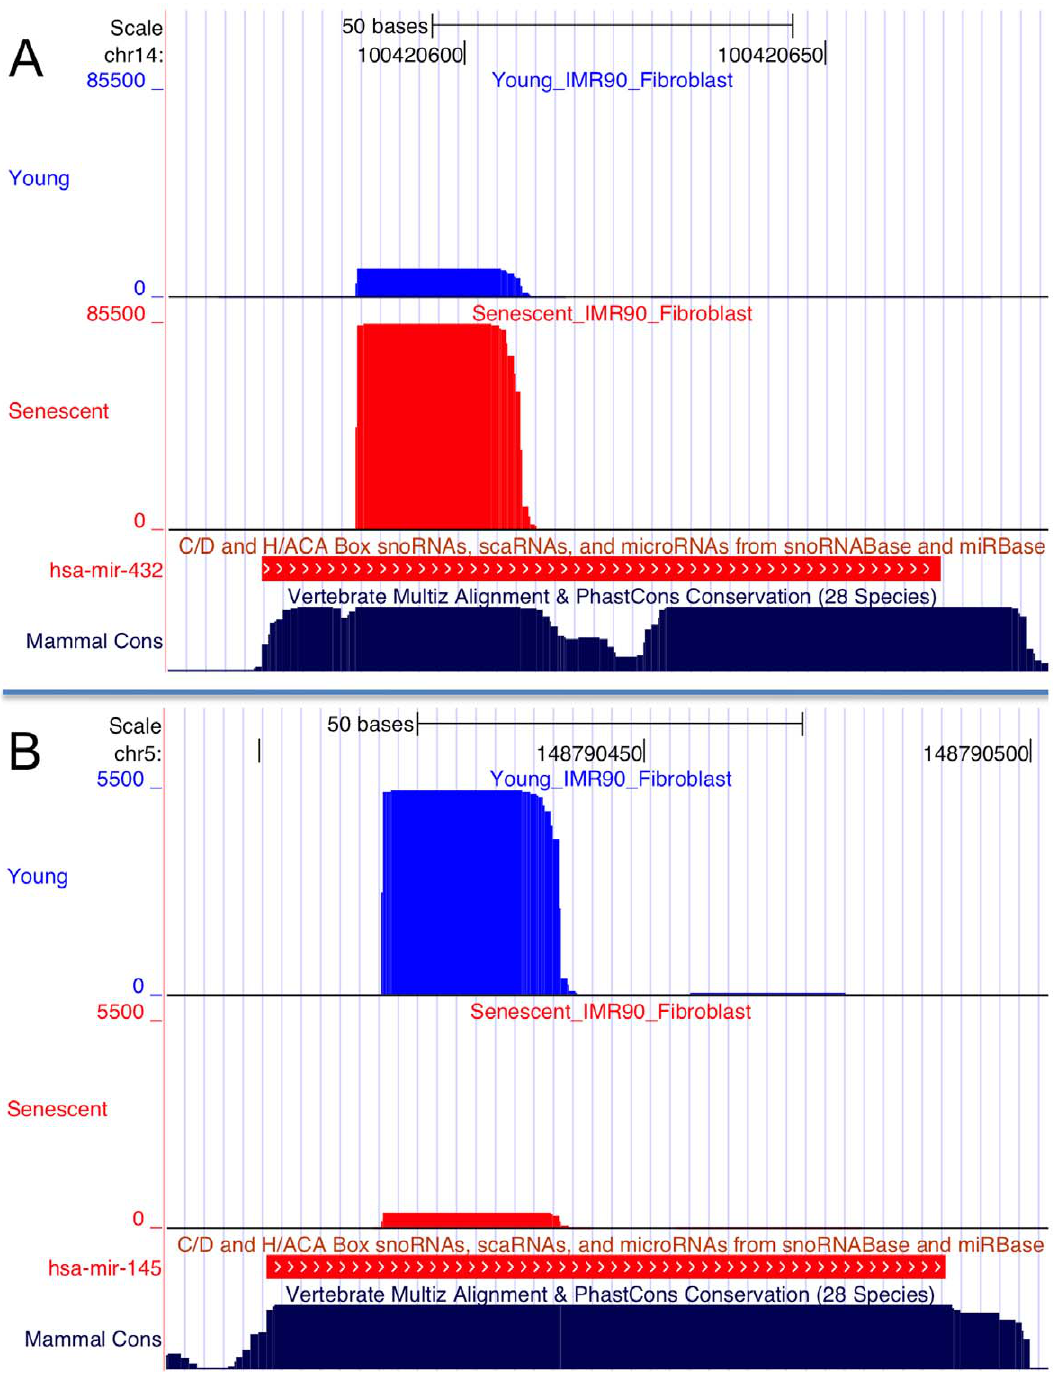
Figure 2. Examples of known miRNAs that are regulated in IMR90 senescence, showing sequence depth. UCSC genome browser views of two miRNAs aligned to the human genome. Reads from young IMR90 cells are shown in blue, and reads from senescent cells in red (number of reads is shown on the y-axis). (A) mir-432; (B) mir-145. The miRNAs (in red) labeled on the snoRNABase/miRBase track represent the miRNA precursors; note that the sequence depth of the mature miRNA, but not the star region, changes in both cases. doi:10.1371/journal.pone.0020509.g002 possible role of this miR-449 induction in cell cycle arrest during senescence, miR-449 has been shown to inhibit cell cycle progression at G1 phase by targeting CDK6 and CDC25A,